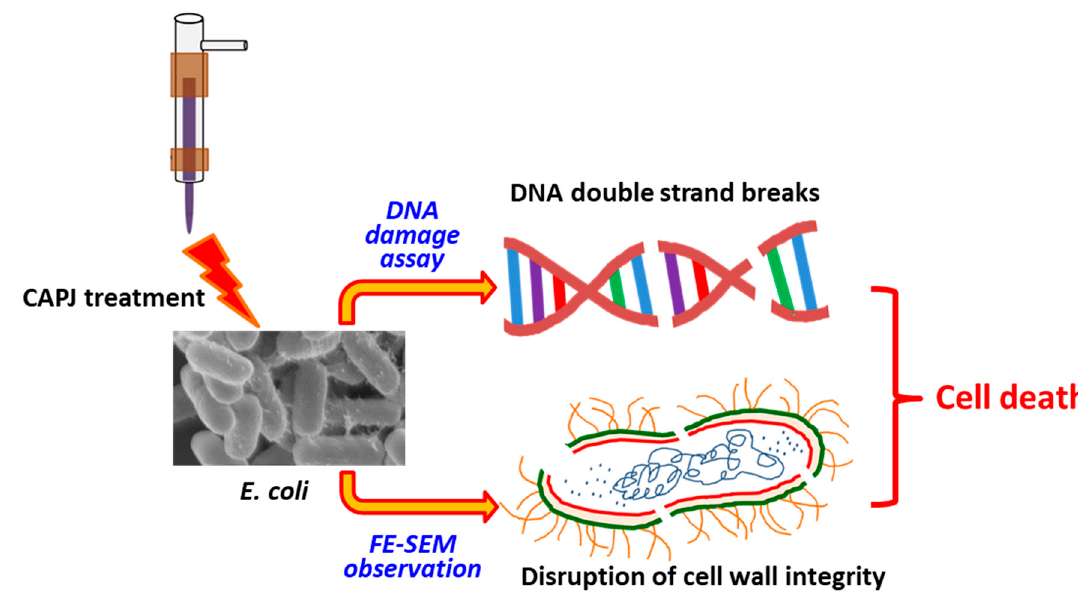
Figure 10. Antimicrobial mechanism of CAPJ treatment. The mechanism of the antimicrobial efficiency by CAPJ is suggested to kill the bacteria by destroying the cell wall of E. coli , damaging its DNA structure.